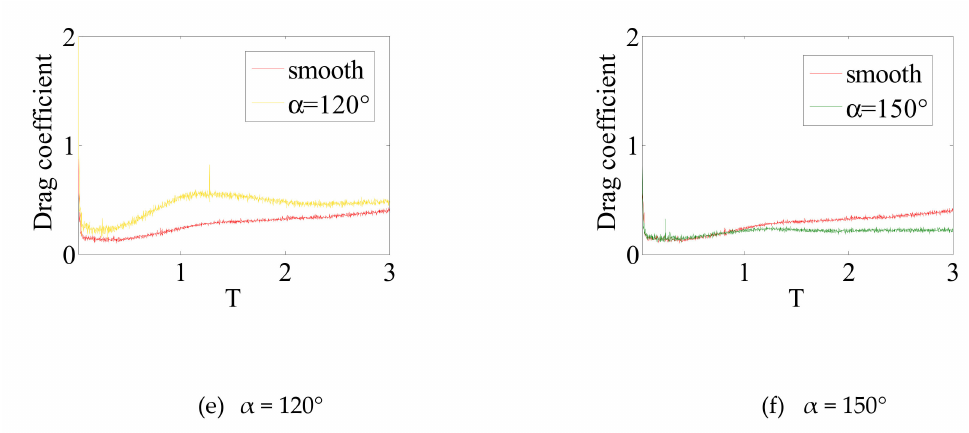
Figure 7. The comparison of the drag coe ffi cients between the smooth cylinder and cylinder with strips for Re =